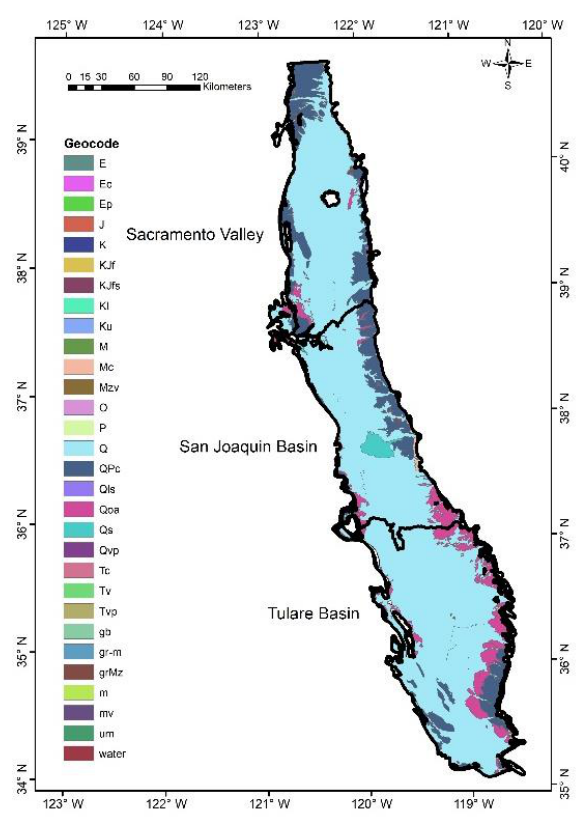
Figure 5. Recharge rate in Central Valley